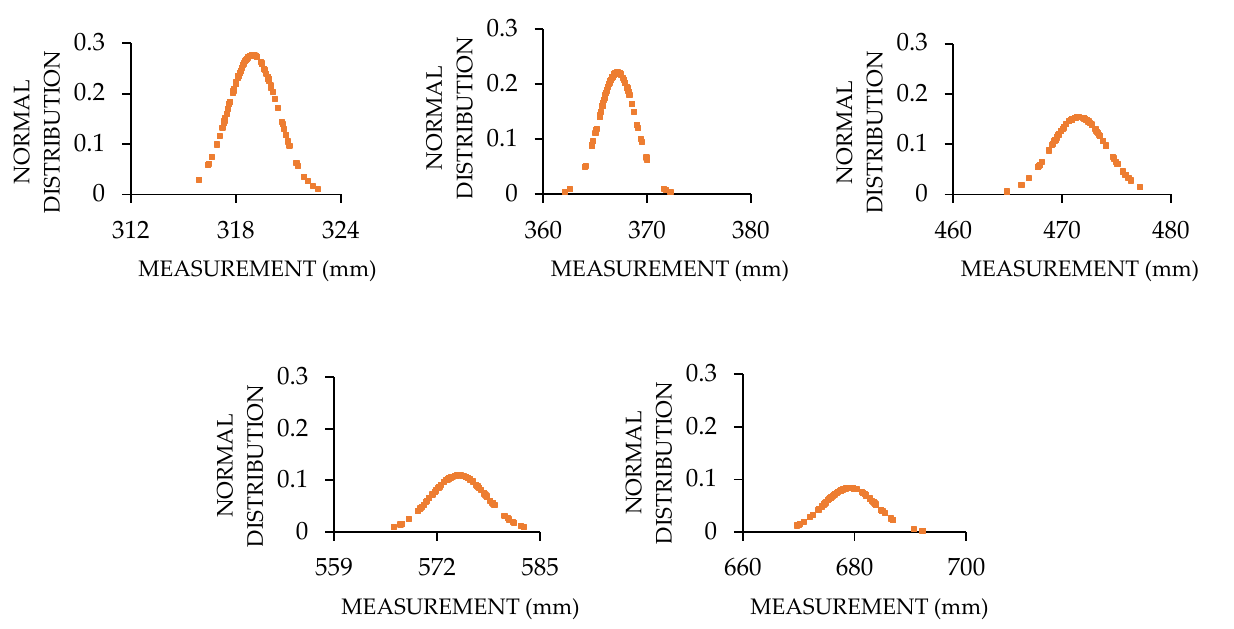
Figure 12. The normal distribution function of VL53L0X for tests with ambient light.